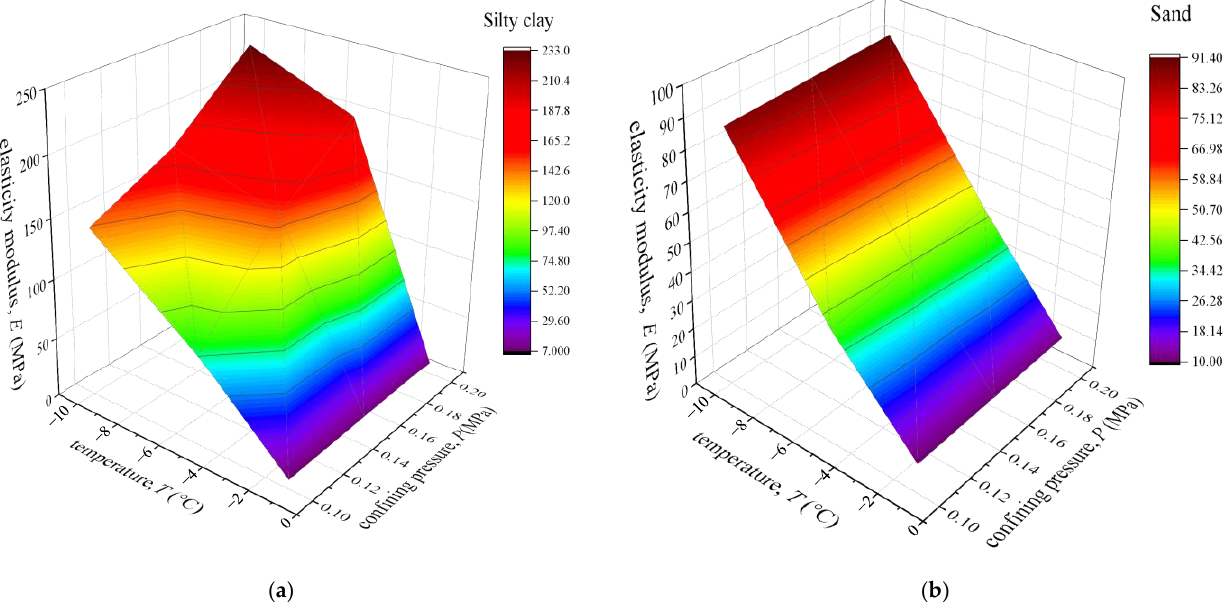
Figure 7. Variation in the elastic modulus versus freezing temperature and confining pressure: ( a ) silty clay and ( b ) sand.